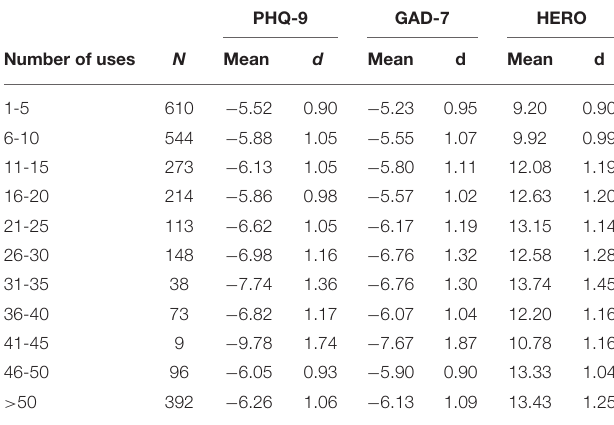
TABLE 7 | Change in PHQ-9, GAD-7, and HERO scores by lifetime psychedelic usage.